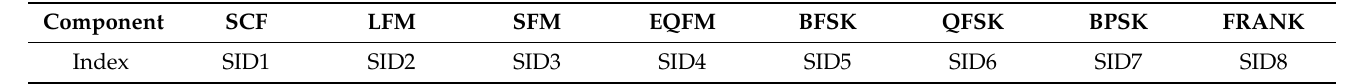
Table 2. The index information for the single-component modulation.